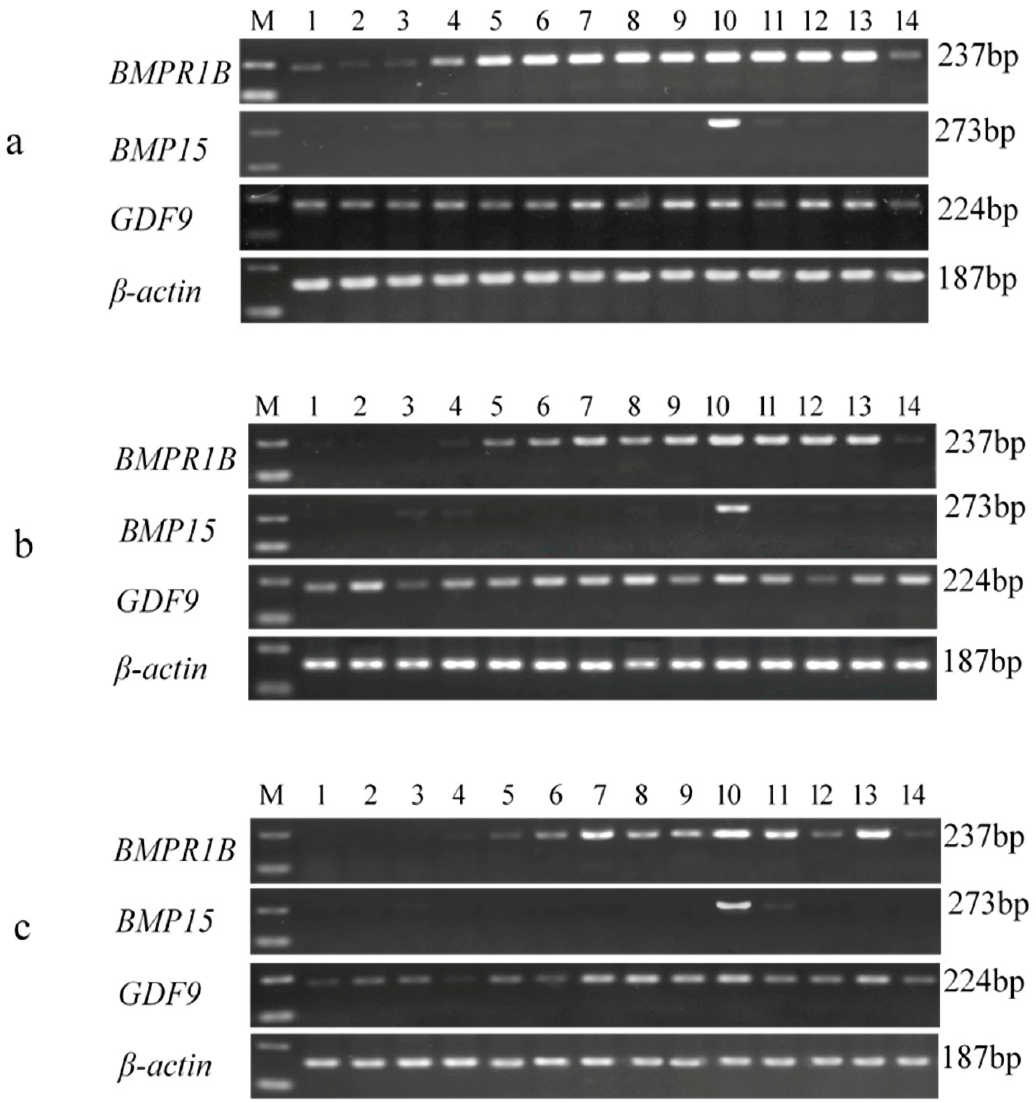
Figure 2. Tissue-specific expression analysis of BMPR1B , BMP15 , GDF9, and β -actin genes in three genotypes of STH sheep. Han BB ( a ), Han B+ ( b ), and Han ++( c ). 1–14: heart, liver, spleen, lung, kidney, brain, cerebellum, hypothalamus, pituitary, ovary, uterus, oviduct, adrenal gland, and duodenum, respectively. M: DL2000 DNA marker.